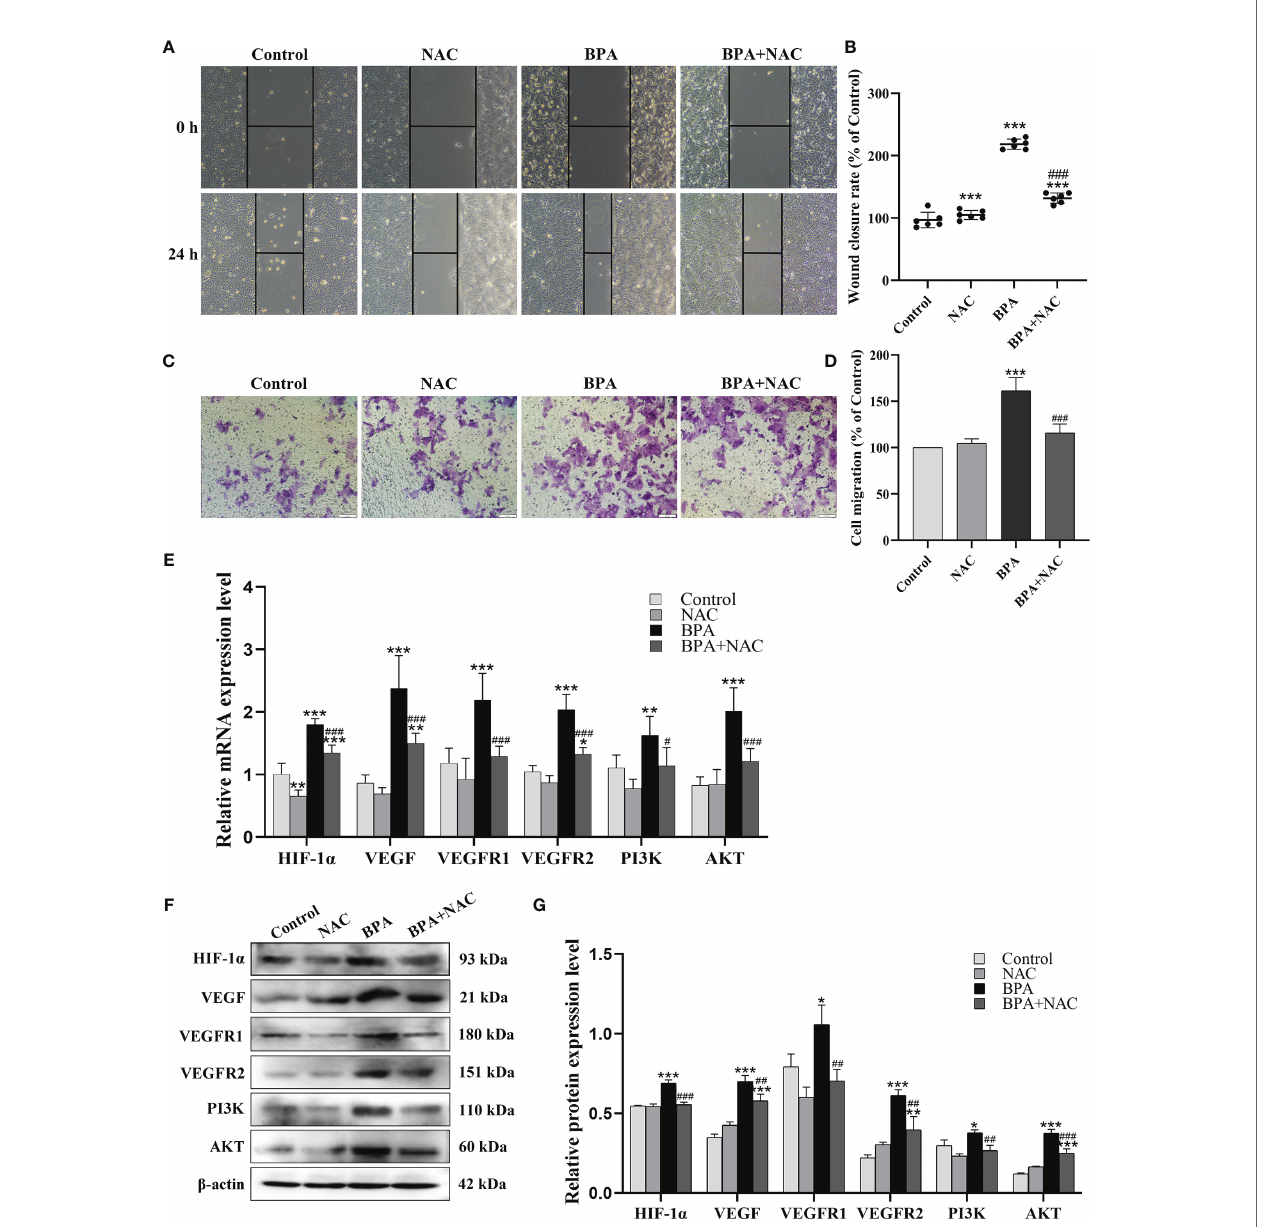
FIGURE 5 | The role of ROS generation on the BPA-promoted migration, invasion, HIF-1 a /VEGF and PI3K/AKT signaling pathway of DLD1 cells. Representative images showed the cell migration (A) and invasion (C) assay. Quantitative analysis of cell migration (B) and invasion (D) rate, n = 6. The mRNA (E) and protein (F) expression of HIF-1 a /VEGF and PI3K/AKT signaling pathway-related biomarkers in DLD1 cells. (G) Quantitative analysis of protein expression associated with HIF- 1 a /VEGF and PI3K/AKT signaling pathway by ImageJ Software, n = 3. Values are expressed as means ± SD, compared with the control group, * p < 0.05, ** p < 0.01, *** p < 0.001; compared with the BPA group, # p < 0.05, ## p < 0.01, ### p < 0.001. ns: no signi fi